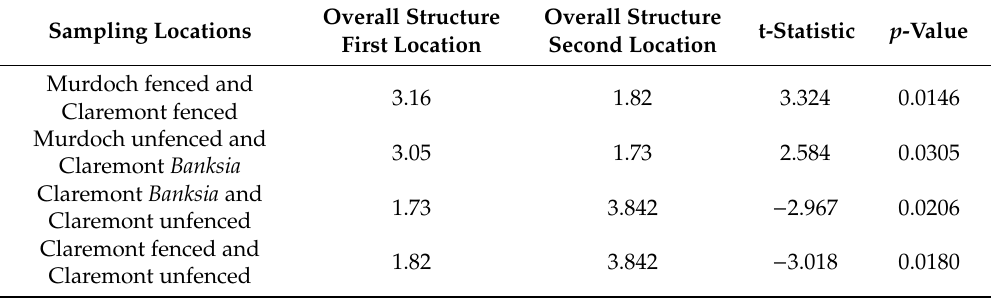
Table 2. Overall structure of the understory along the transects and outcomes of paired t-tests comparing the baseline means for each of the five sampling locations. Reported values for the structure of the understory are mean values based on the semiquantitative measure of the highest row (0 to 10) with indigenous vegetation in every